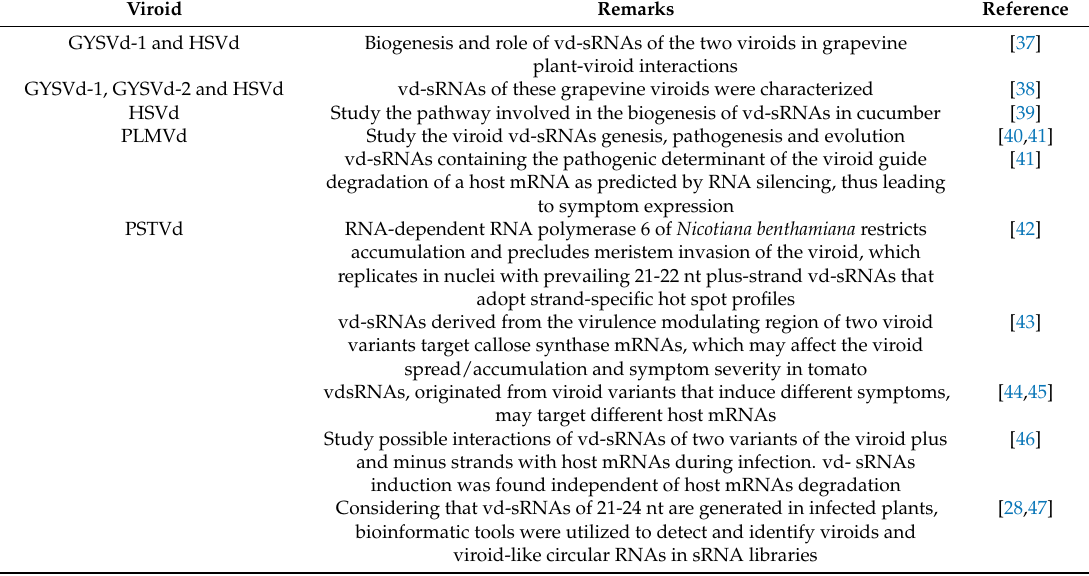
Table 4. vd-sRNAs: characterization, biogenesis pathway and target host mRNAs identified by